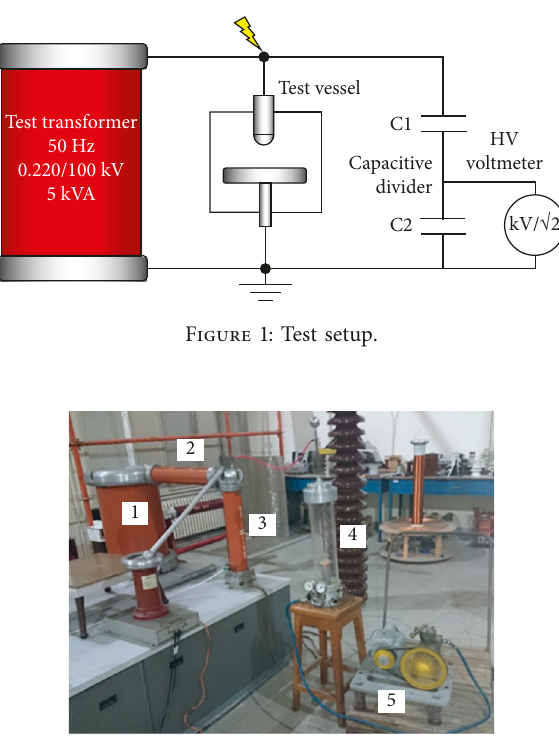
Figure 2: Test setup at high voltage laboratory of ITU. (1) Test transformer; (2) current limiting resistor; (3) capacitive divider; (4) test vessel; (5) vacuum pump.